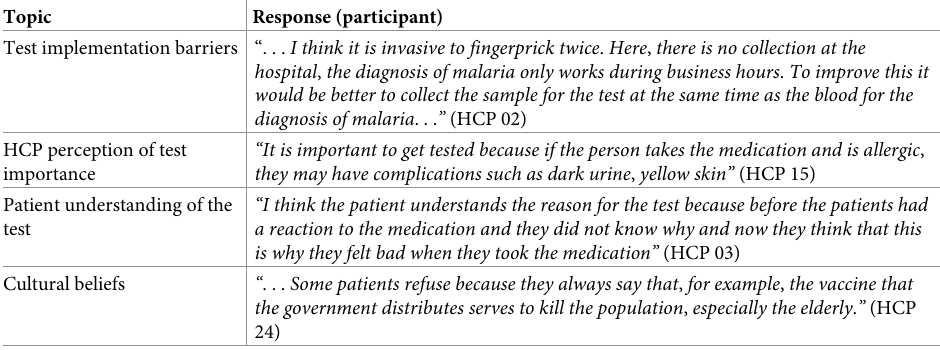
Table 2. HCPs perceptions on G6PD test comprehension and